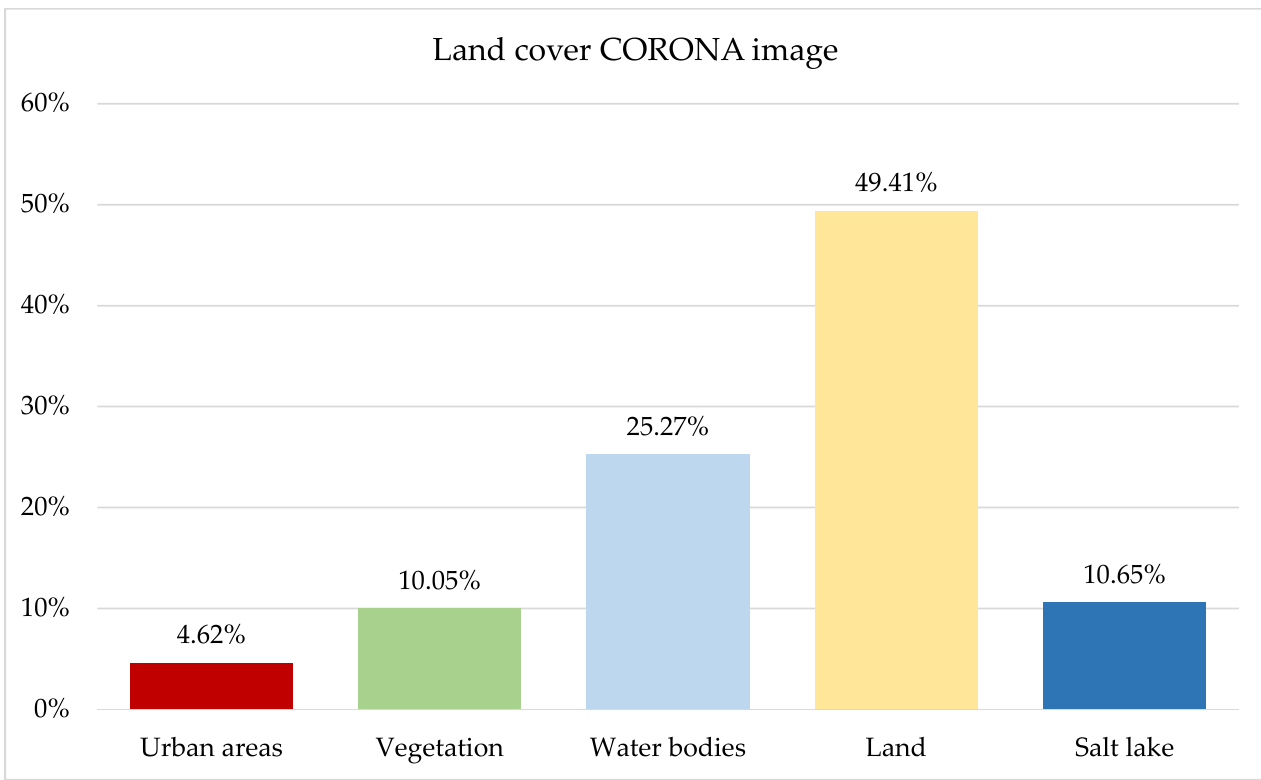
Figure 7. Land cover proportions (%) for the five main classes of the classification analysis.